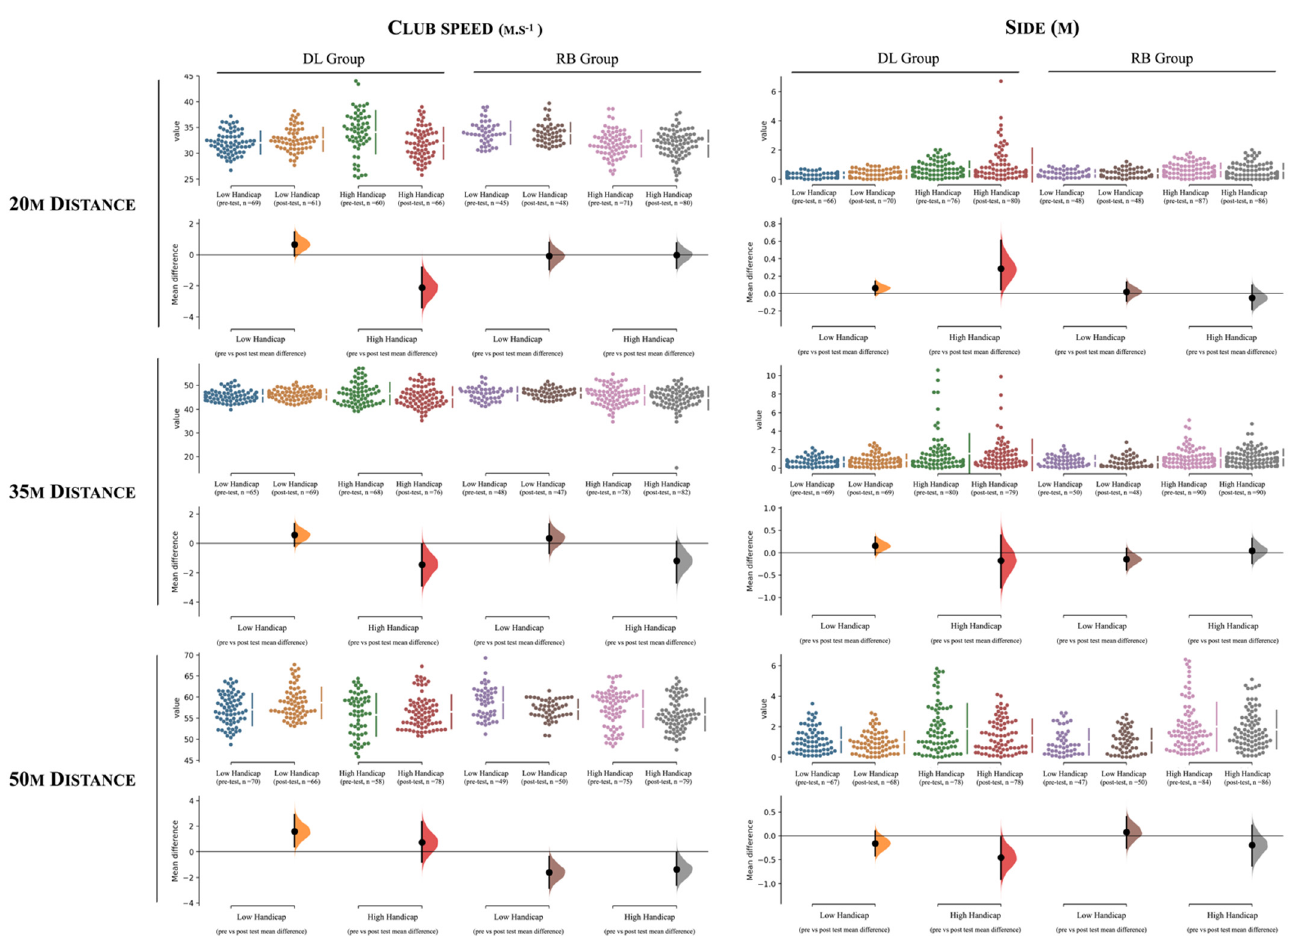
Figure 4. The mean difference for 4 comparisons according to: (i) the club speed and side and to (ii) distances (20, 35 m, and 50 m) are shown in the above Cumming estimation plot. The raw data are plotted on the upper axes; each mean difference is plotted on the lower axes as a bootstrap sampling distribution. Mean differences are depicted as dots; 95% confidence intervals are indicated by the ends of the vertical error bars [45]. When the mean difference is negative, should the distribution curve show on the other side? In the present way, it is somewhat confusing. DL = differential learning; RB = repetitive-based.